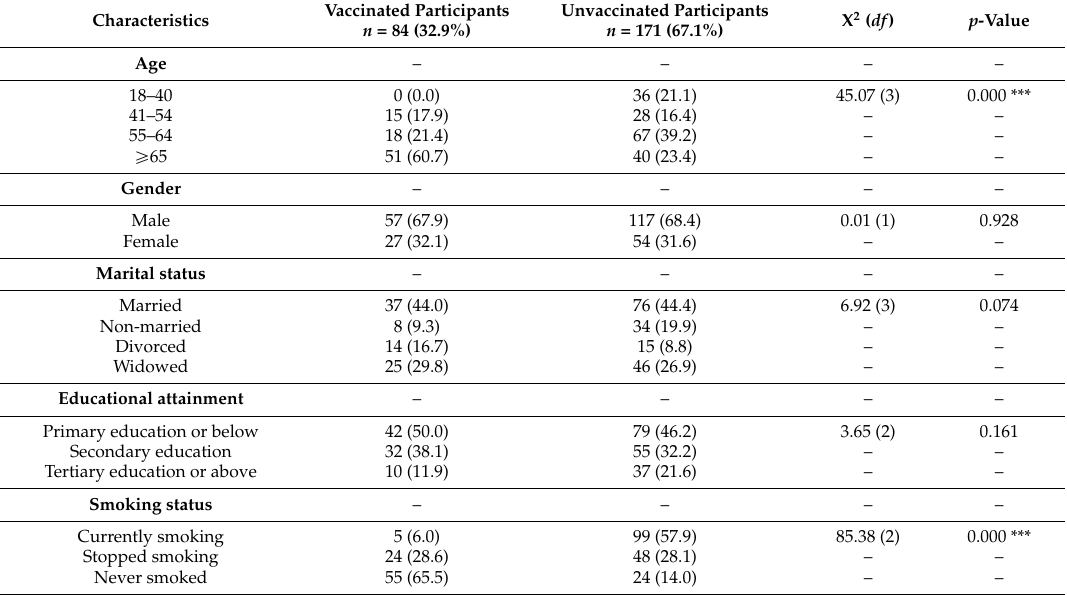
Table 1. Comparison of the characteristics of vaccinated and unvaccinated participants.